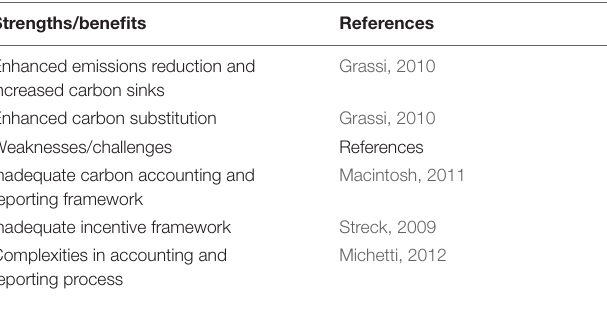
TABLE 7 | Key challenges related to LULUCF